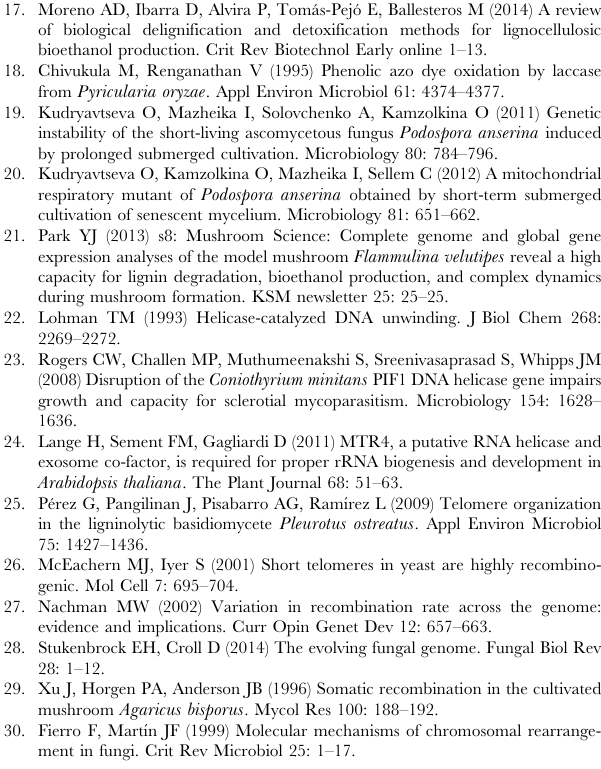
indicates the residues that are identical in the three sequences. . and arrows indicate the sequence amplified using the SCAR marker primers that discriminated the degenerates. = and arrows indicate the genomic sequences corresponding to the HELICc and HepA domains. The telomeric repeating units (TTAGGG) are in shaded boxes. Figure S2 Deduced map of the genomic region corre- sponding to the degenerate-specific sequence of the wild-type (W1), degenerate (D4) and KACC42780 strains. Unknown but deduced sequences are shown in boxes indicated with a broken line. The arrow indicates the direction of transcription of the putative helicase gene. The black boxes in